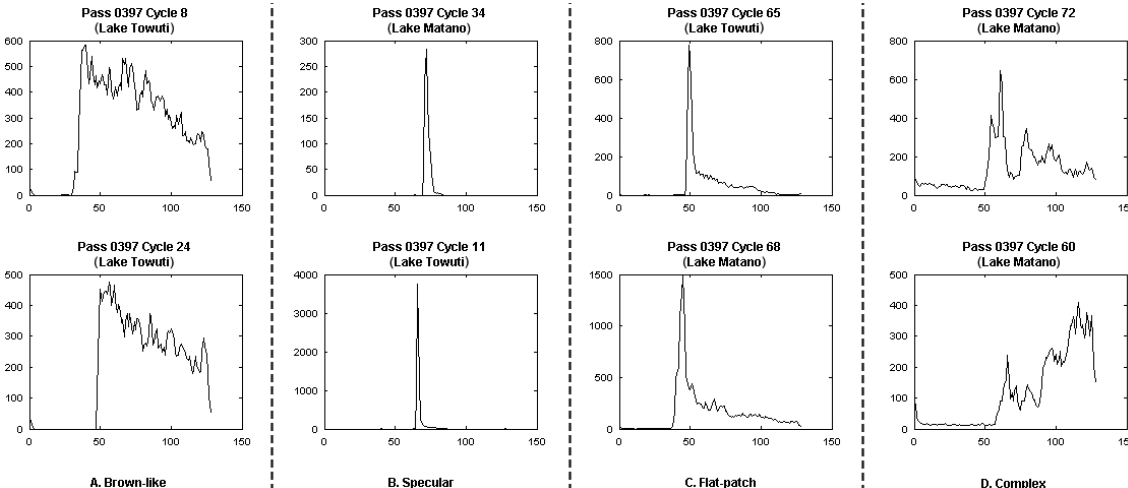
Figure 3. General categories of waveform